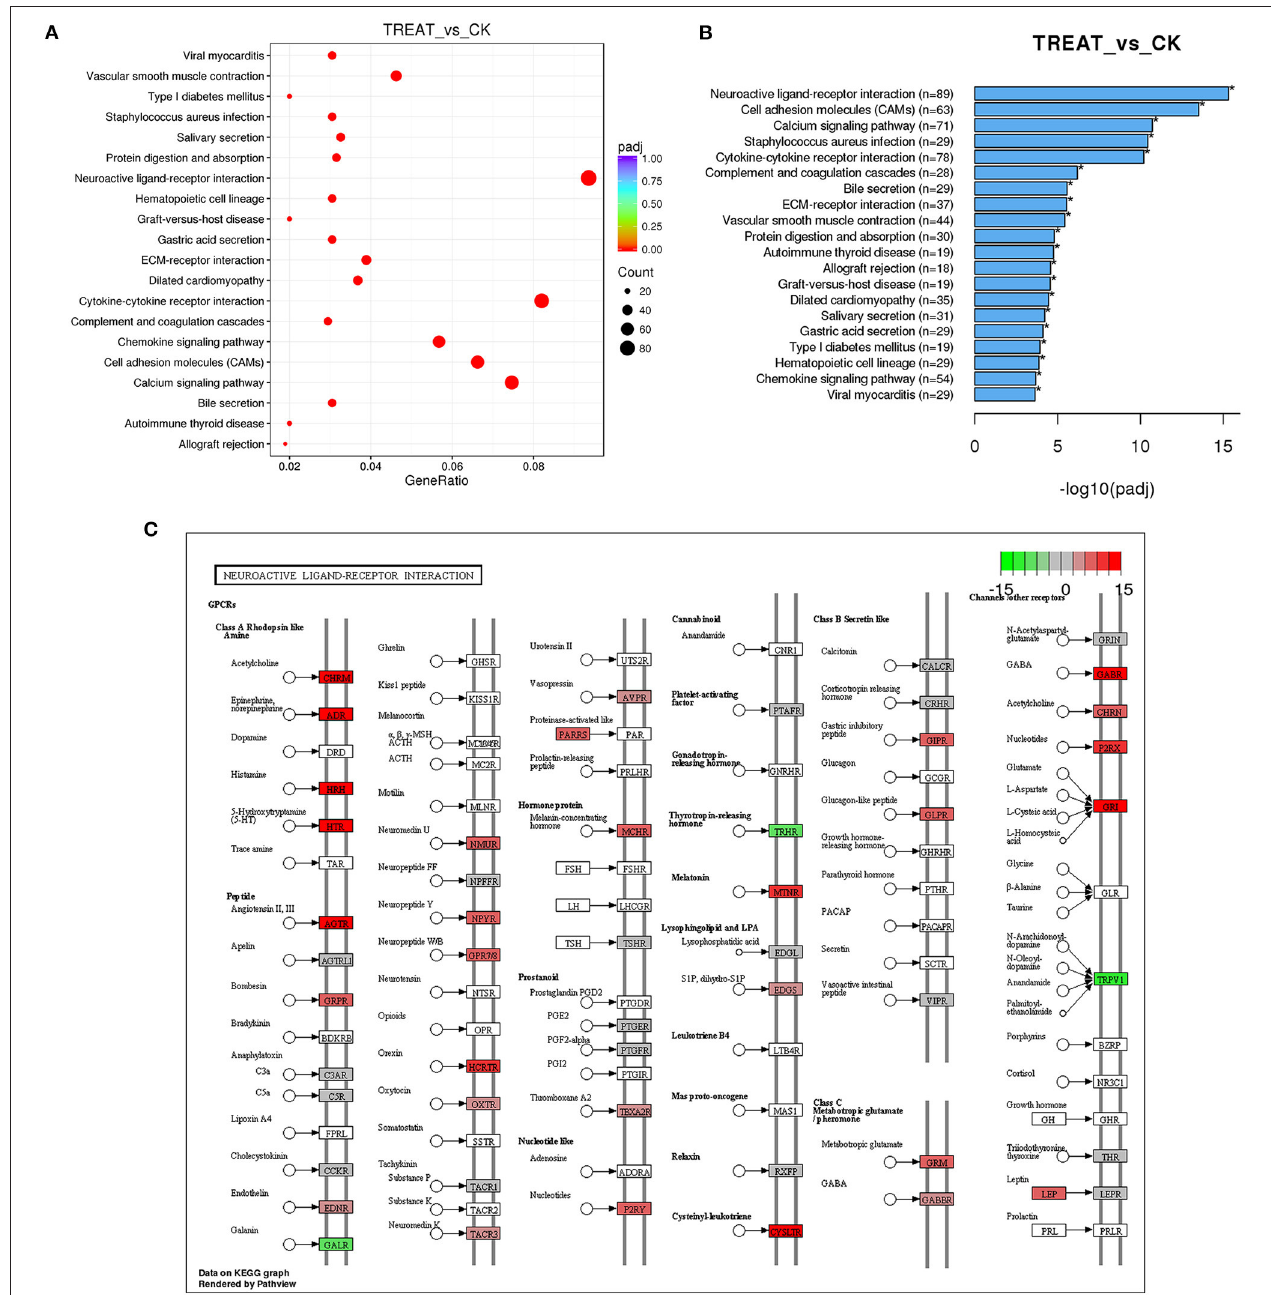
FIGURE 4 | Signaling pathway analysis of differentially expressed lncRNAs. (A) The KEGG pathway analysis demonstrates that the genes are enriched in multiple pathways. (B) Lists of the most affected pathways. (C) Neuroactive ligand–receptor interaction signaling pathway map. Red in (C) indicates upregulated genes; green in (C) indicates downregulated genes; lncRNAs, long non-coding RNAs; KEGG, Kyoto Encyclopedia of Genes and Genomes.